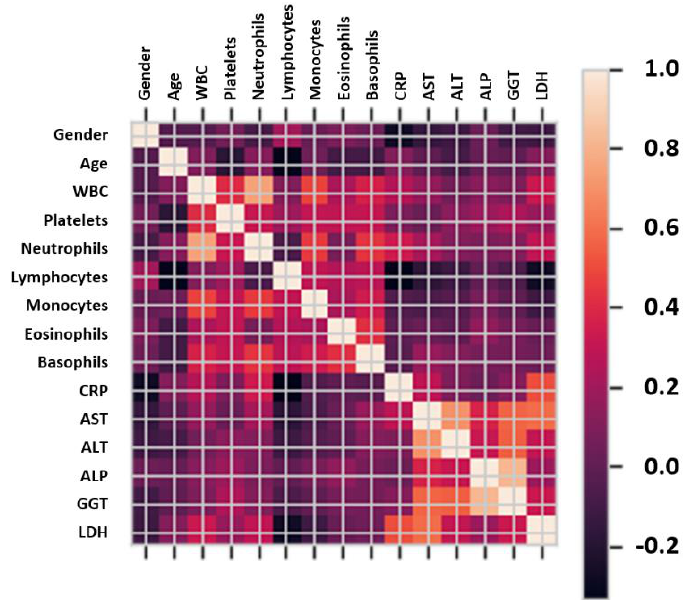
Figure 2. Correlation matrix for the different features of the analyzed blood sample dataset.